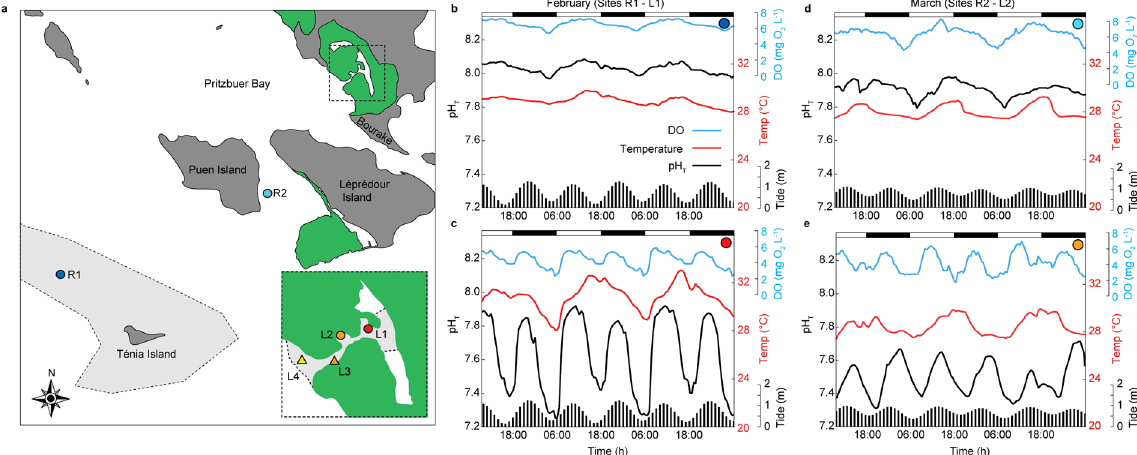
Figure 1. Map of the semi-enclosed lagoon system in Bouraké (New Caledonia) and reference reef sites along with their physico-chemistry. ( a ) Location of the study sites L1–L4 (shown in insert) inside the mangrove system (green areas), and reference reef sites R1, which is characterised as an exposed outer-reef (indicated by grey hashed areas), and R2, sheltered between two islands (indicated by dark grey areas). ( b – e ) Physico- chemical parameters measured in February for sites R1 ( b ) and L1 ( c ), and March for sites R2 ( d ) and L2 ( e ). pH in total scale (pH T ), dissolved oxygen (DO, mg L − 1 ), and temperature (°C) were coupled to the tidal cycles (x axes, bottom; vertical bars) and daily light cycles (x axes, top; horizontal bars). The base data for the map ( a ) were collected from map tiles at www.openstreetmap.org (© OpenStreetMap contributors,